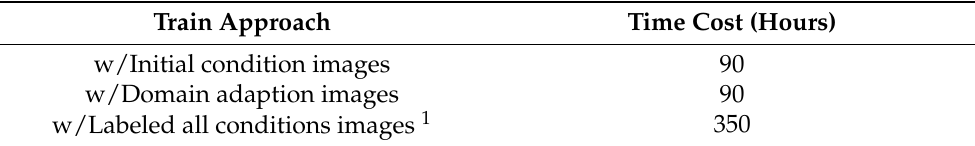
Table 5. Manual labeling cost for bale detection with different